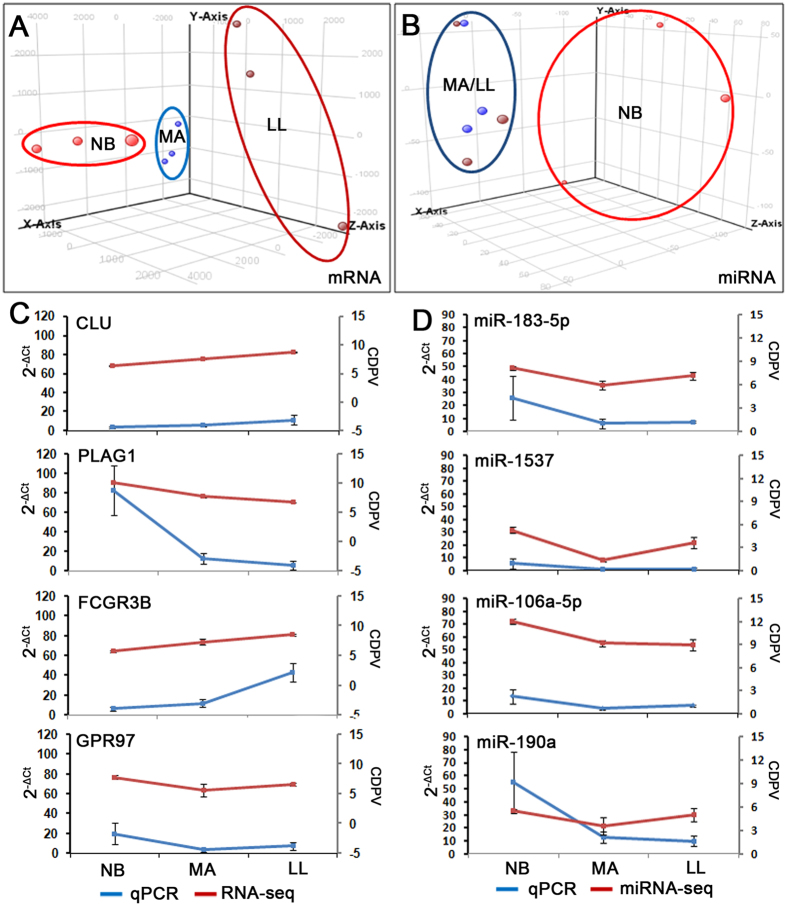
Global analyses of the miRNAomes and transcriptomes of human CD4+ T cells during the aging process.(A) Stage-transitive transcriptome changes of human CD4+ T cells. (B) Stage-transitive miRNAome changes of human CD4+ T cells. Human CD4+ T cell samples are projected onto the three-dimensional space captured by PCA. Each of the staged aging samples is colored as indicated. (C,D) Validation of sequencing data by quantitative RT-PCR of known genes and miRNAs in CD4+ T cells. Experiments were performed using residual CD4+ T cell RNAs used for the RNA-seq. Data are represented as the means ± SDs.